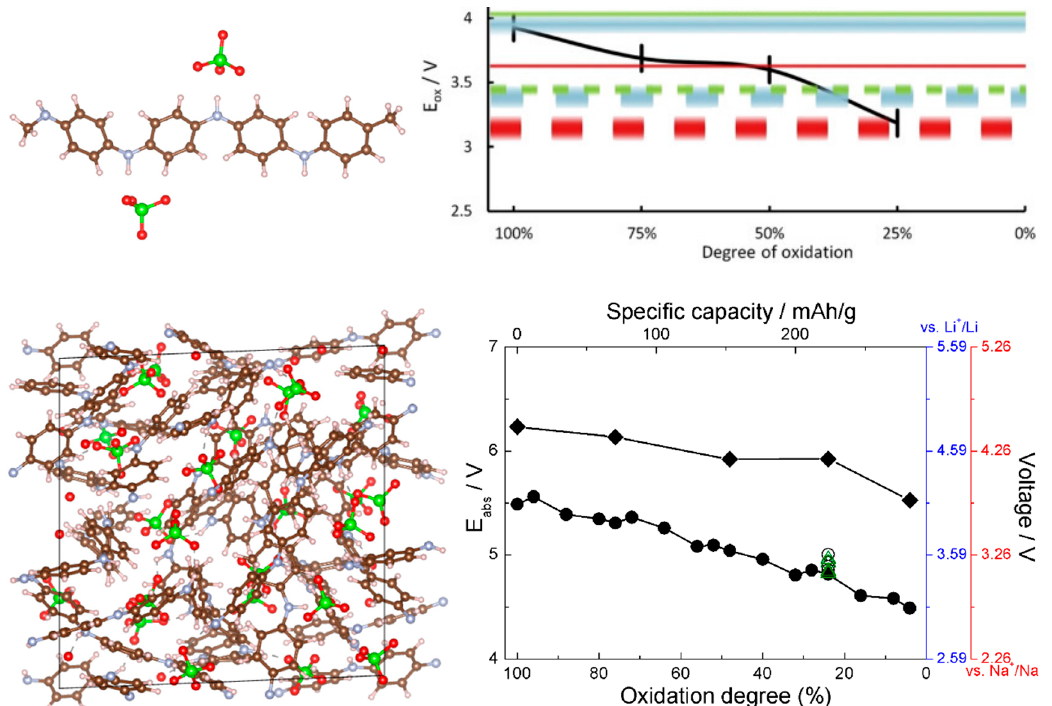
Figure 7. Top left: the structure of the oligomeric model of PANI showing coordination of ClO 4 − anions. Top right, black curve: the computed voltage profile (for a Li ion battery) from the oligomeric model. Reproduced from [46] with permission from Elsevier. Bottom left: a simulation cell of solid PANI with intercalated ClO 4 − . Bottom right: the computed voltage profile for Li and Na ion batteries from the solid state model for PANI (curve with round symbols) and CN-functionalized PANI (curve with rhombic symbols). Reproduced from [45] with permission from the PCCP Owner Societies.